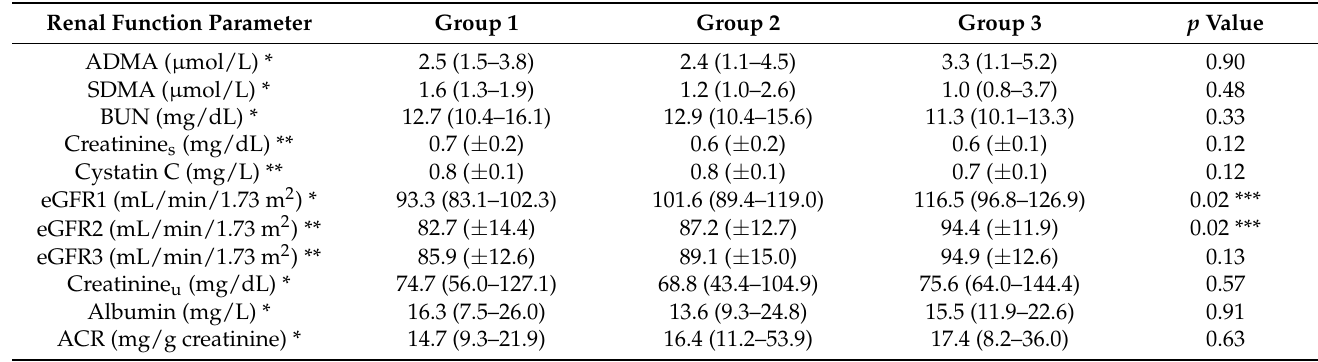
Table 4. Renal assessment in the study groups.